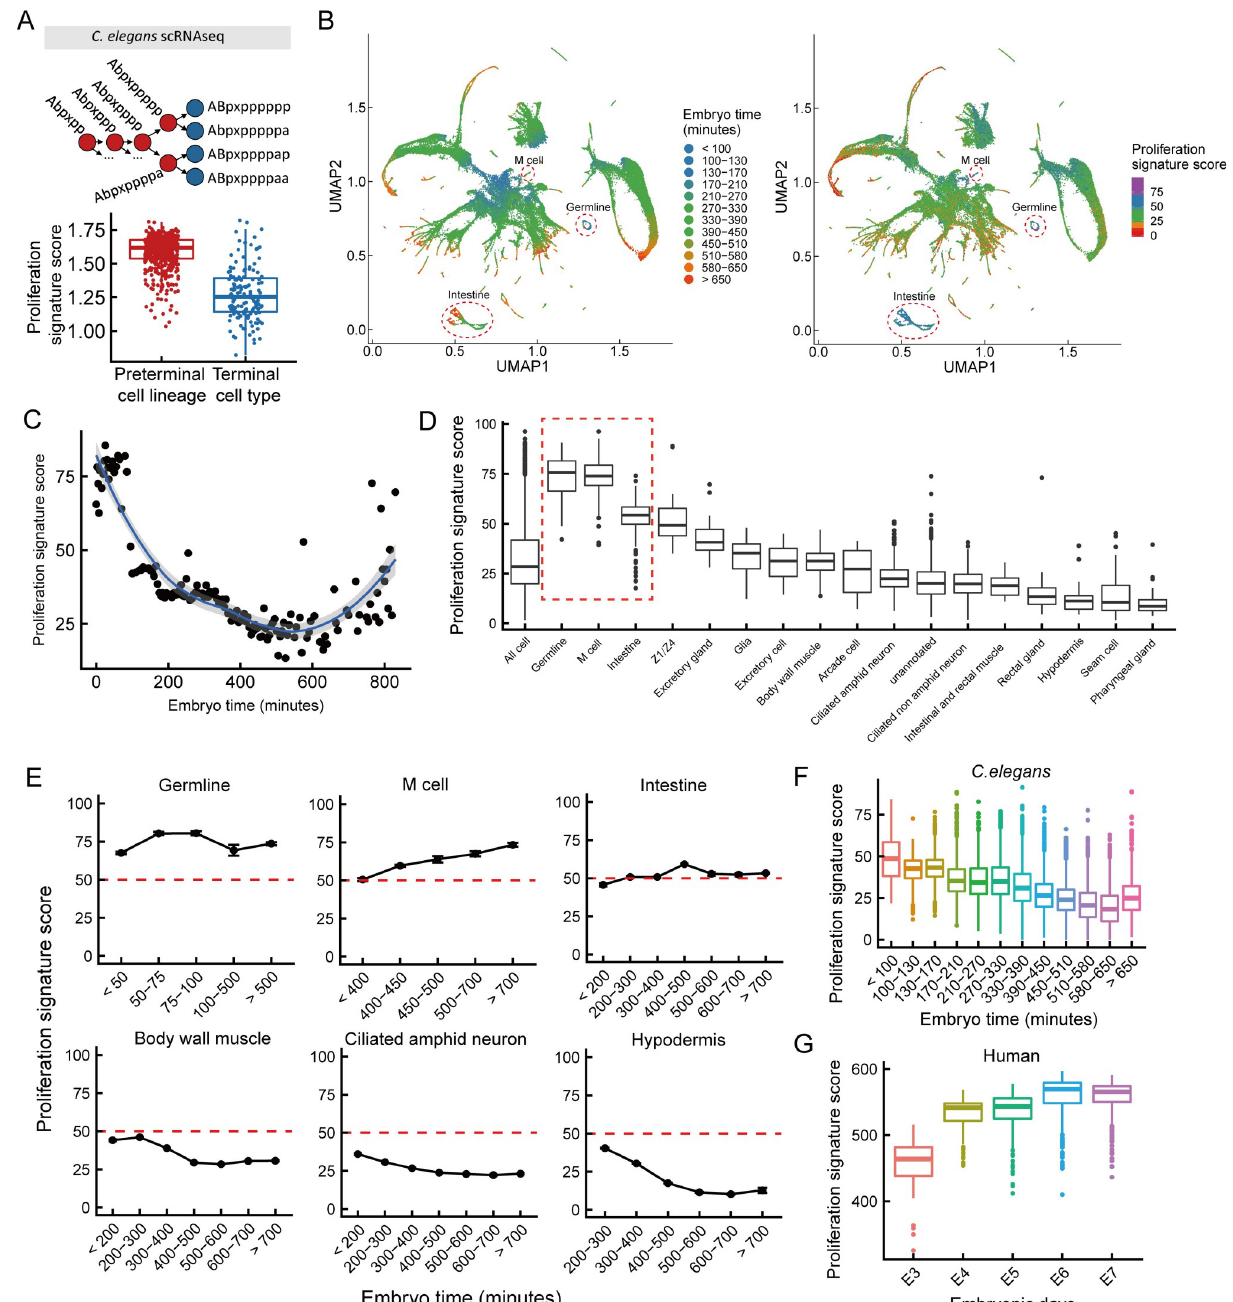
Fig 5. Proliferation signature of cell development. (A) A cartoon showing four terminal cells, and a partial linage showing the final four generations of preterminal cells. Comparison of single-cell proliferation signatures between preterminal cell lineage and terminal cell types (t-test, p = 4.9 × 10 − 41 ). (B) UMAP projection of 89,701 cells. Cells in the left panel are colored by estimated embryo times; in the right panel by proliferation signature score. (C) To calculate the proliferation signature score (y-axis) at each time point (x-axis) cells are binned by embryo time, and the mean proliferation signature score for all cells in the same bin is calculated. The spearman correlations are -0.65 (p = 9.3 × 10 − 19 ) for binned data and -0.42 (p < 2.2e-16) for unbinned data. (D) Boxplots (line shows median, boxes interquartile range) of proliferation signature score for all cells with embryo time > 650min. (E) Temporal dynamics of proliferation scores of select cell lineages, showing the average proliferation score for all single cells in that lineage, at each time point. (F-G) Boxplot of C . elegans (F) and human (G) proliferation signatures as a function of developmental time, from scRNAseq data.